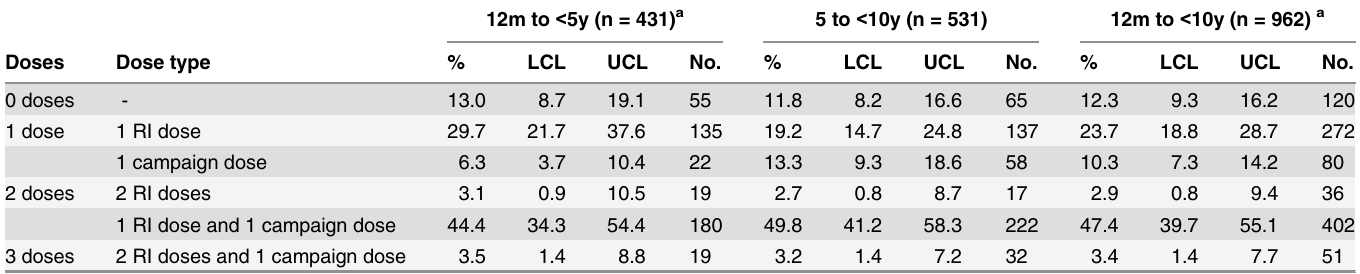
Table 5. Estimated proportion of children by age group and number of measles doses received at the end of the phase 2 measles vaccination cam- paign, Jharkhand, 2012. 12m to < 5y (n = 431) a 5 to < 10y (n = 531) 12m to < 10y (n = 962)